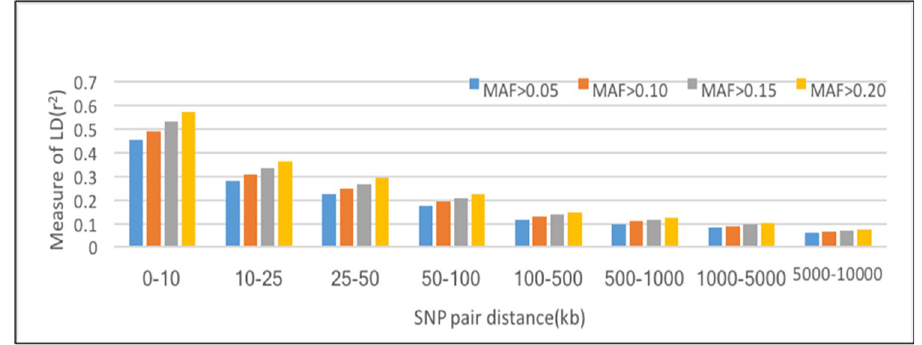
Fig 3. Mean r 2 estimates at different physical distances for different minor allelic frequency (MAF) thresholds.